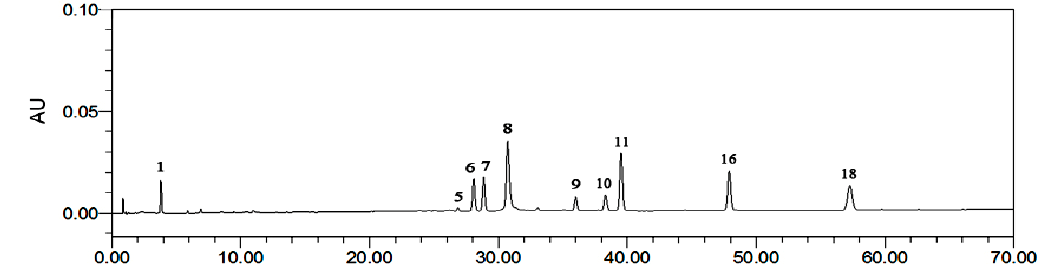
Figure 4. The reference fingerprint of R. rugosa : (1) GA (3.783 min); (5) 2-phenylethyl- O - β - D -glucopyranoside (26.9 min); (6) quercetin-3-O-(2 ′′ - O - β - D -glucopyranosyl)- β - D -glucopyranoside) (28.0 min); (7) juglanin (28.9 min) (8) EC (30.7 min); (9) avicularin (36.0 min); (10) quercetin (38.3 min); (11) kaempferol-3 -O -sophoroside (38.9 min) (16) hyperoside (48.9 min); (18) astragalin (57.3 min).